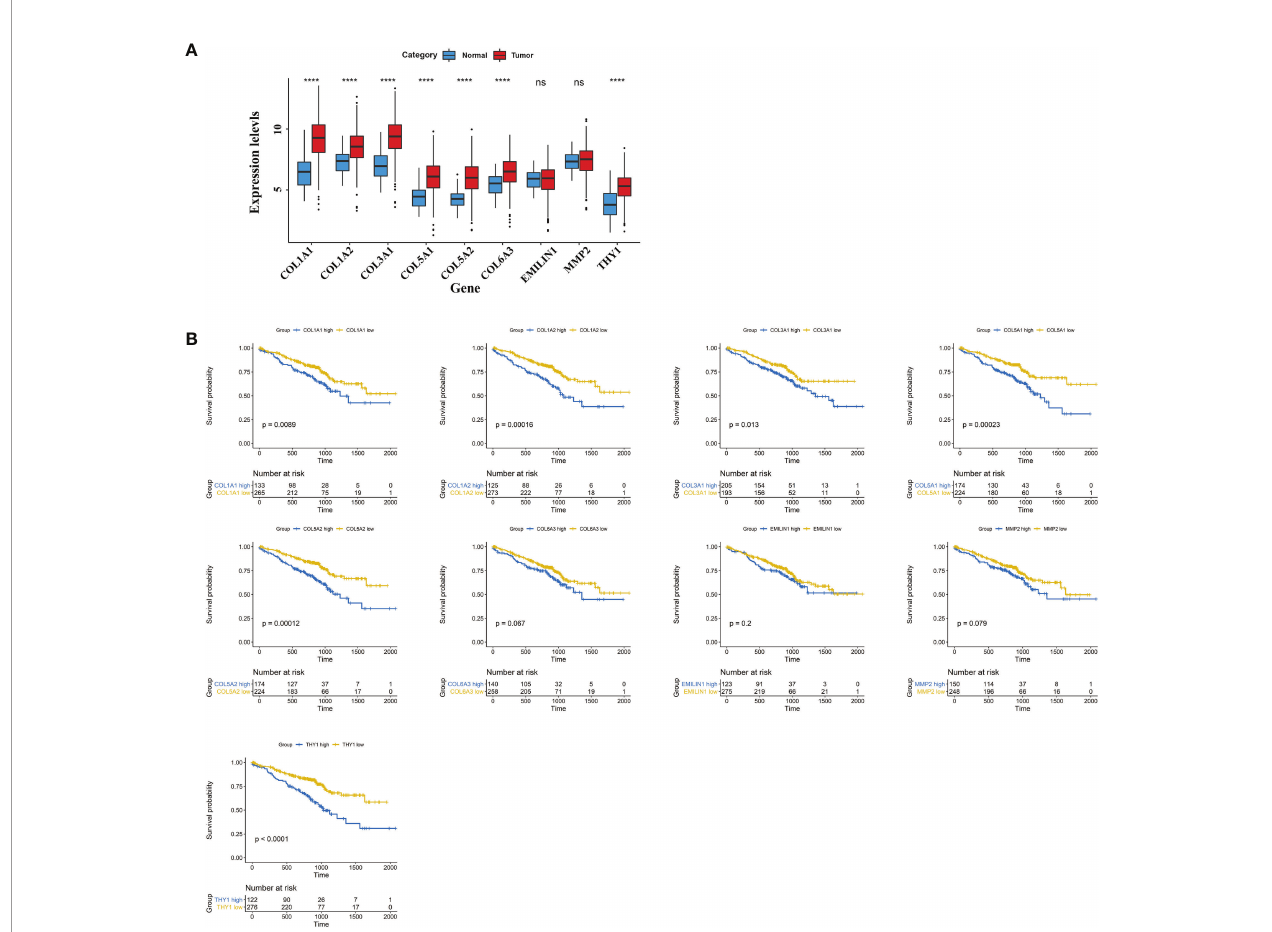
FIGURE 5 | Clinical characteristics of hub genes in pink module. (A) mRNA expressions of nine hub genes in cancer tissues of LUAD and normal lung tissues. (B) Survival plots of the signi fi cant genes by Kaplan Meier test. The data were obtained from the GEO website. ns, no signi fi cance; **** p <